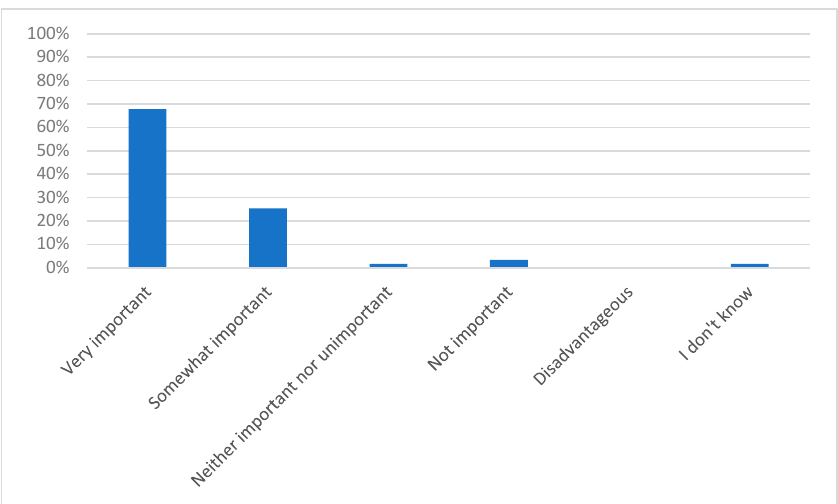
Figure 2. How important is information (cyber) security to your daily job and activities? (Asia and Europe).